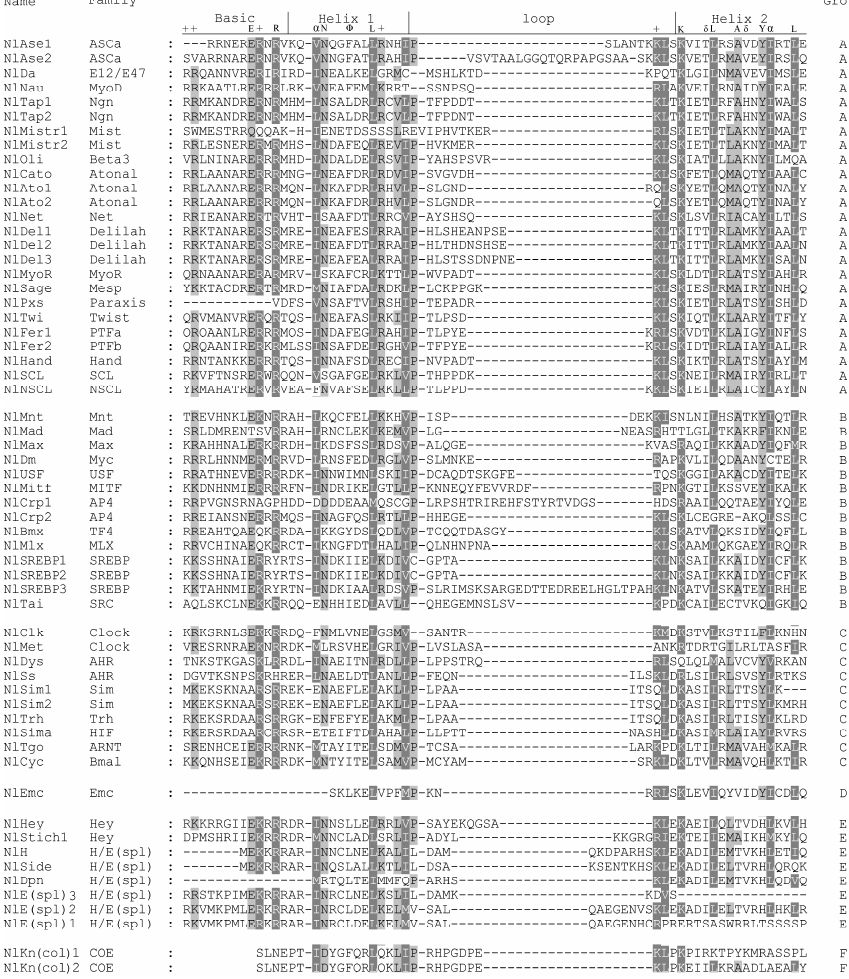
Figure 1. Multiple sequence alignment of basic helix ‐ loop ‐ helix (bHLH) motifs of the 60 Nilaparvata lugens basic helix ‐ loop ‐ helix ( NlbHLH ) sequences. The scheme at top illustrates the element of the predicted model and the boundaries of the basic, helix 1, a loop and helix 2 regions within the bHLH domain following that of Atchley et al. (1999) and Ferre ‐ D’Amare et al. (1993), respectively. The dark gray shades indicate identical residues. The light gray shade indicates conserved residues. Hyphens denote gaps. The family names and high ‐ order groups have been organized according to Table 1 of Ledent et al. (2002).